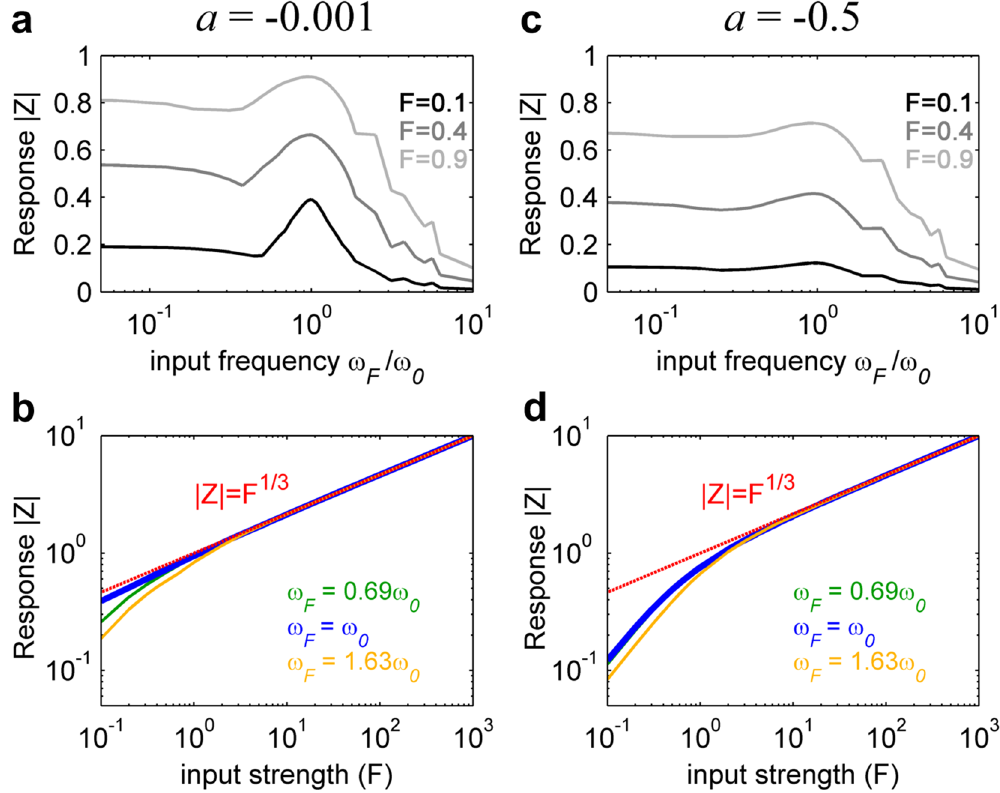
Figure 5. Single node response to external stimulus for two different dynamic working regimes. In ( a ) the response – the absolute value of the simulated complex signal |Z| – of a single node is shown as a function of the input frequency for different input strengths F . ω 0 is the intrinsic frequency, which was here set to 1. ( b ) displays the model response as a function of the input strength for different input frequencies. The red line shows hypothetical power law behaviour. Both ( a ) and ( b ) are simulated with the bifurcation parameter a very close to the bifurcation at a = 0. ( c ) and ( d ) show the same as ( a ) and ( b ), with the difference that the bifurcation para meter used for the simulations was set to a negative value in the noisy regime of the model. Note that for a close 1 to the bifurcation the model response follows the power law ∝ Z F 3 for an input frequency equal to ω 0 ,